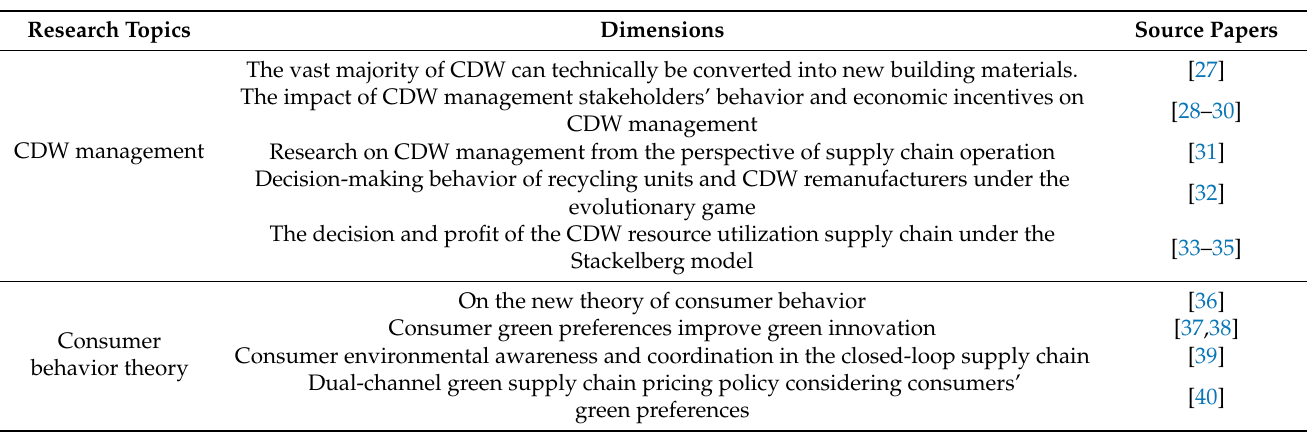
Table 1. Research related to construction and demolition waste, consumer behavior theory, and the supply chain under government